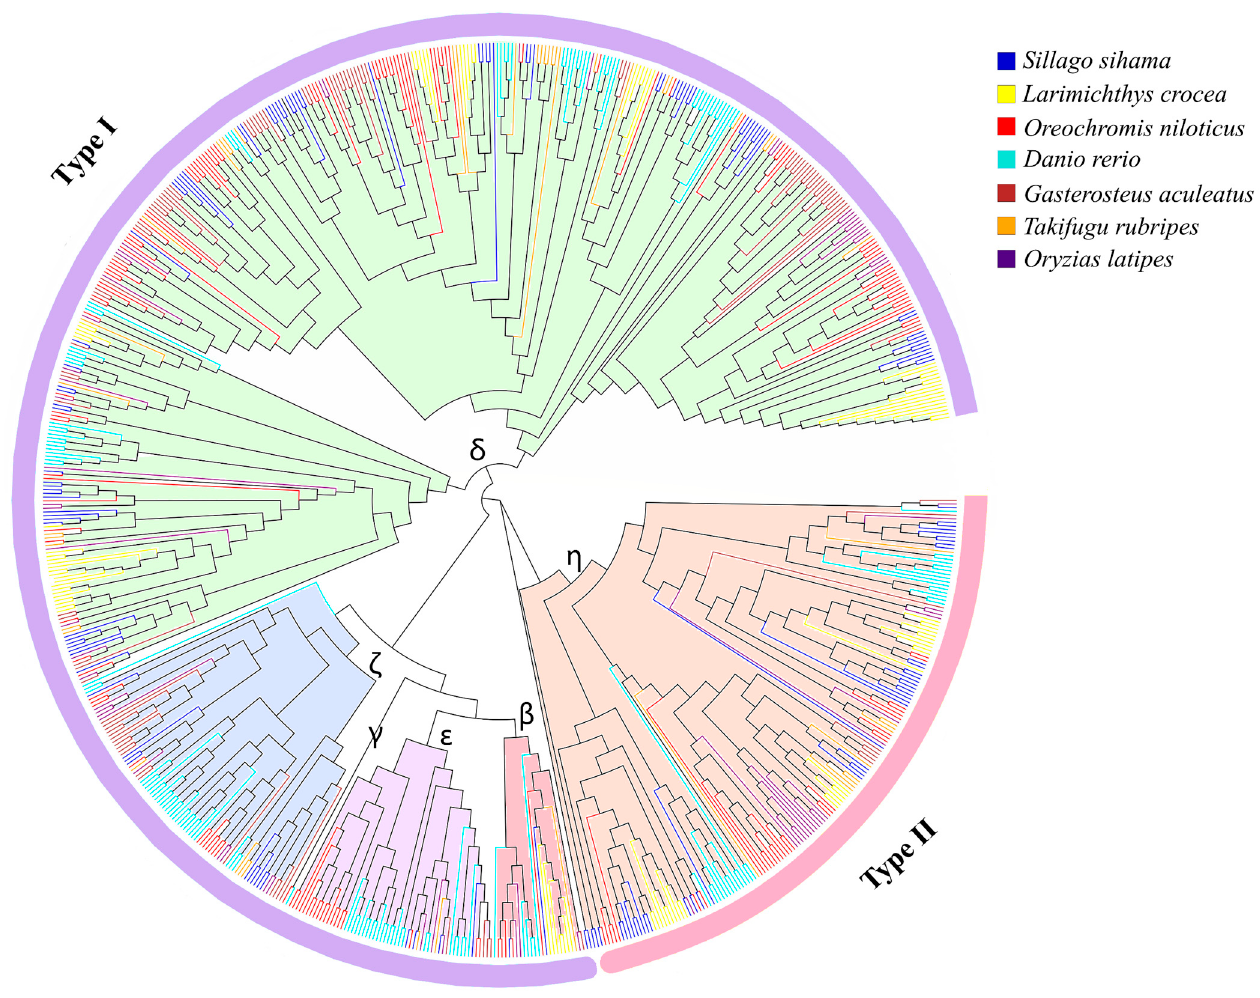
Figure 1. Phylogenetic trees of OR genes from S. sihama and six teleost fish functional genomes ( n = 745). Phylogenetic trees were constructed using amino acid sequences from seven species (bootstrap copy number: 1000). The phylogenetic tree is divided into six groups ( β , γ , δ , ζ , ε , and η ). Groups named β to η are signed on the branches. The type I genes are surrounded by the purple line, and the type II genes are surrounded by the pink line.